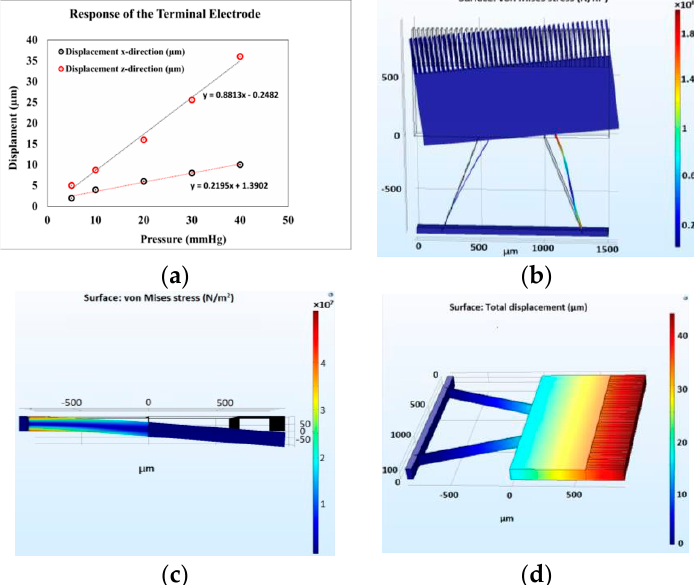
Figure 3. Displacement of the cantilever structure: ( a ) in x and z-axis directions for varying pressure (0– 40 mmHg), ( b ) in x-axis direction for 5 mmHg pressure, ( c ) in z-axis direction for 5 mmHg pressure, and ( d ) displacement distribution in z-axis direction for 40 mmHg